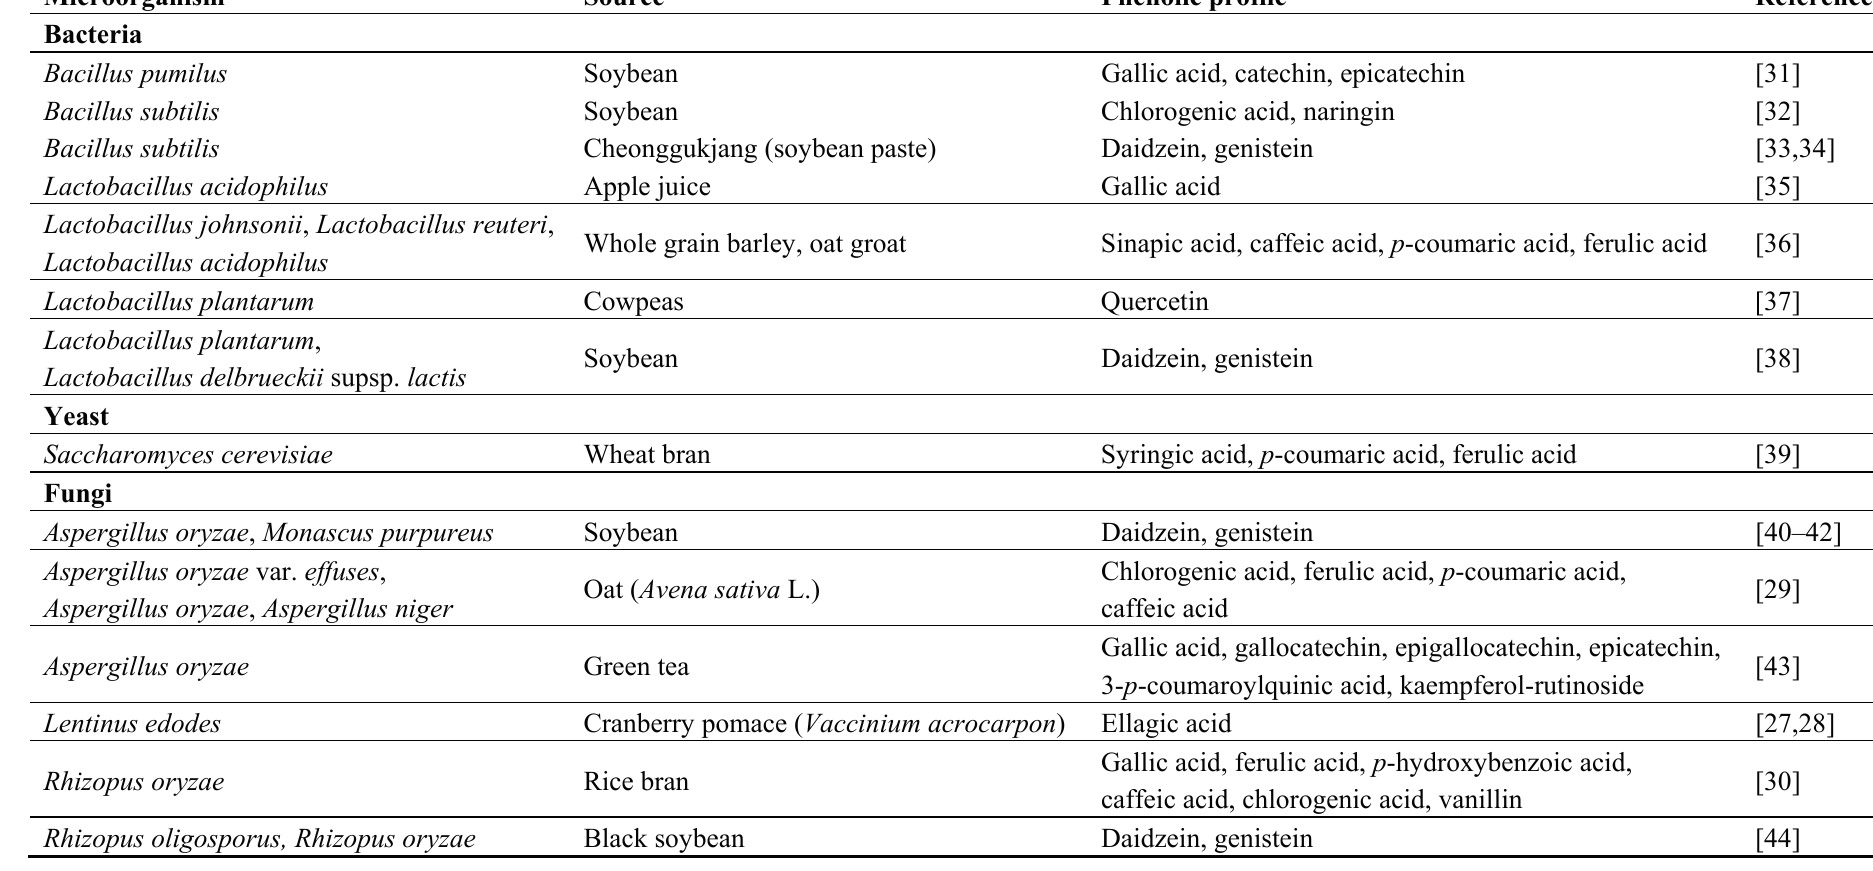
Table 1. The effect of microbial fermentation on the increase in phenolic compounds from various plant-based